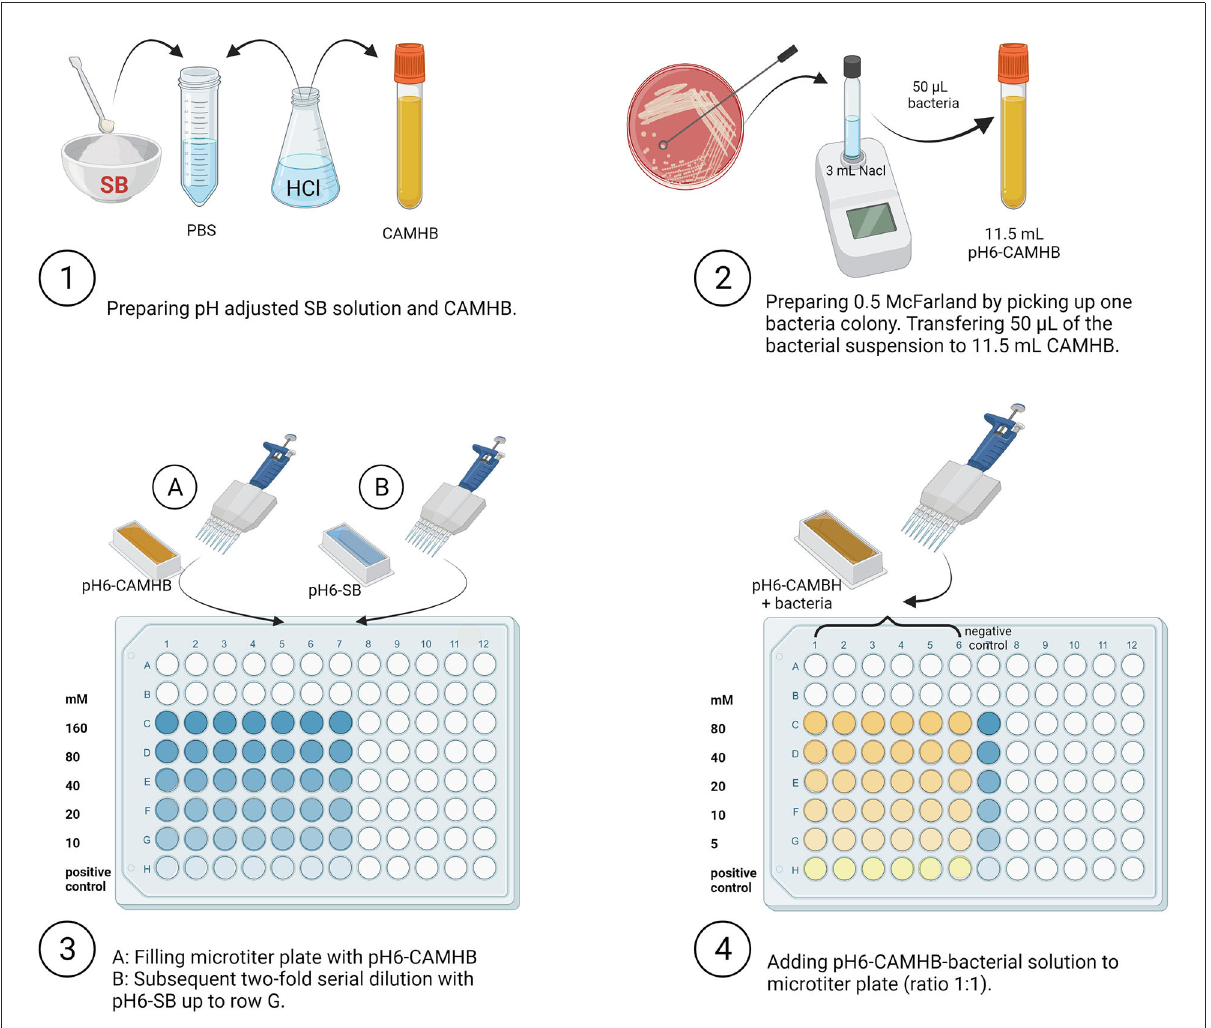
FIGURE1 Overview of experimental set-up. SB, Sodium butyrate; PBS, Phosphate Buffer Saline; HCl, Hydrochloric acid; CAMHB, Cationic Adjusted Mueller-Hinton broth; NaCl, Sodium chloride (Created with BioRender.com).